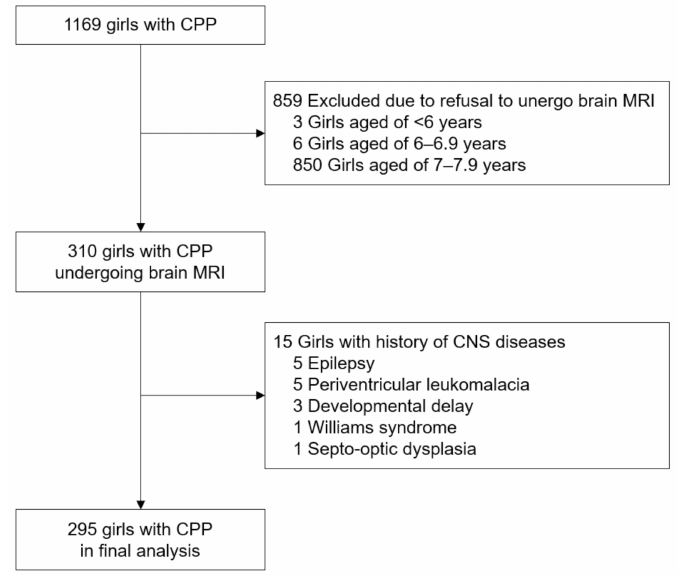
Figure 1. Flowchart of girls with CPP enrolled in the